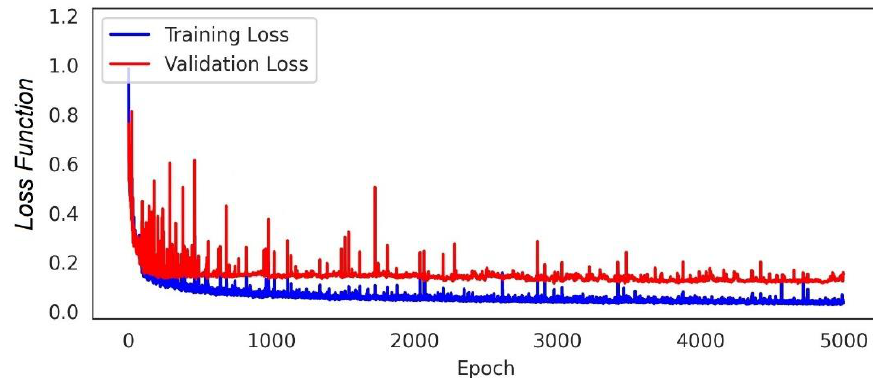
Figure 7. The loss function for the DNN model.